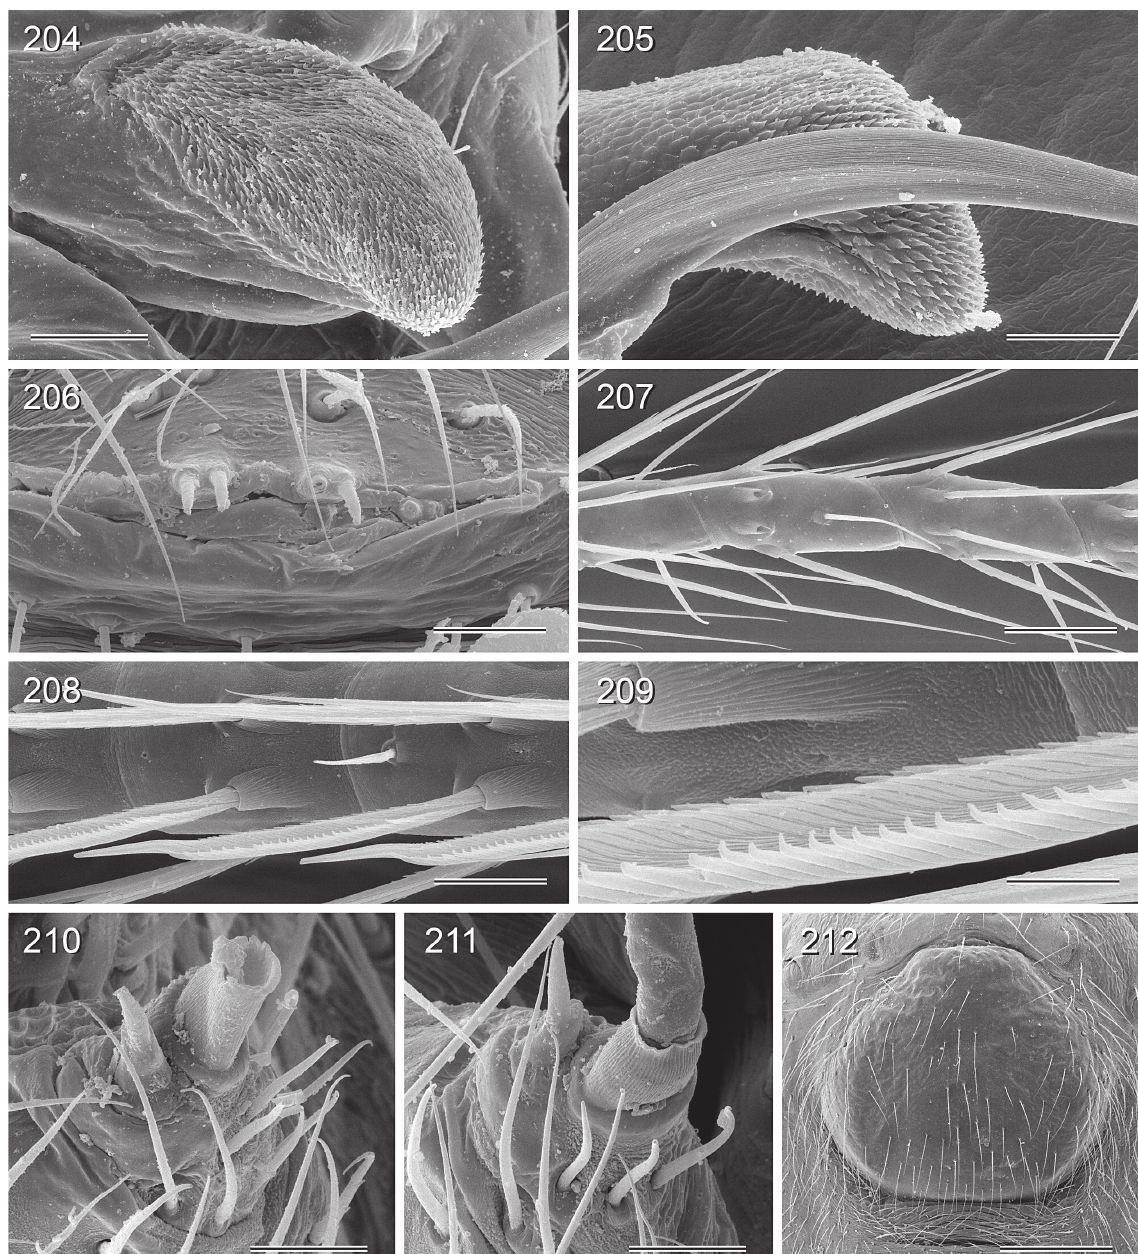
Figs 204–212. A. omayan Huber, 2005. 204 . Left procursus tip (ventral lamina), retrolateral view. 205 . Right procursus tip (pointed sclerite and ventral lamina), prolateral view. 206 . Male gonopore. 207 . Detail of male tarsus 1. 208–209 . Comb-hairs on male tarsus 4. 210–211 . Male and female ALS. 212 . Epigynum. Scale lines: 204 = 50 µm; 205 = 40 µm; 206, 208 = 30 µm; 207 = 60 µm; 209 = 8 µm; 210–211 = 20 µm; 212 = 400